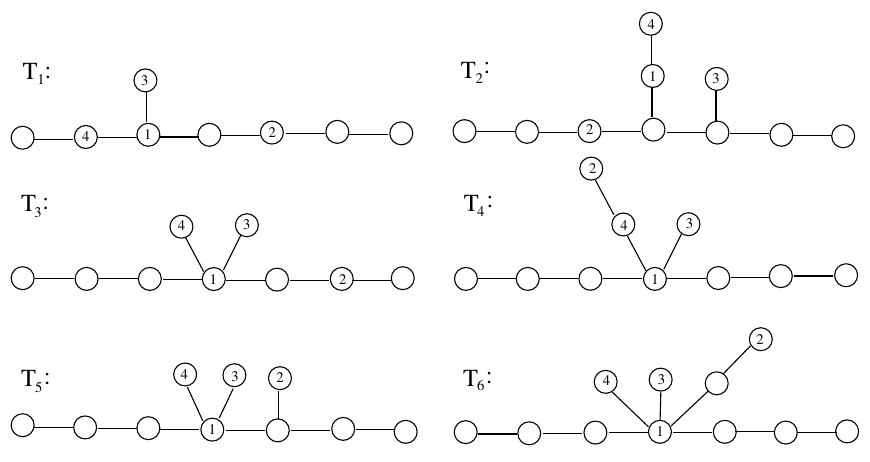
Figure 9: Minimal trees in a tree T with diam( T ) = 6 and ˜ γ ( T ) = 4 .